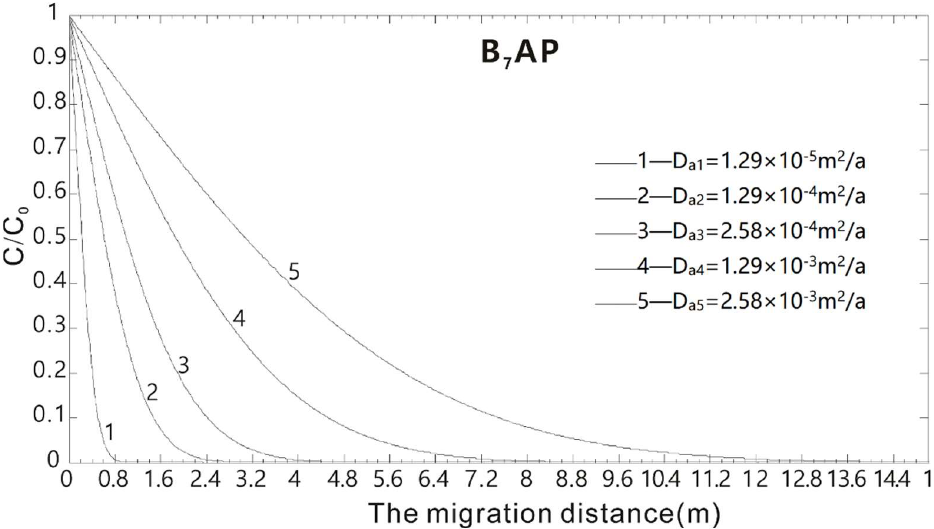
Figure 8. Effect of apparent diffusion coefficient on migration of uranium in B 7 AP buffer material (t = 10,000 a).